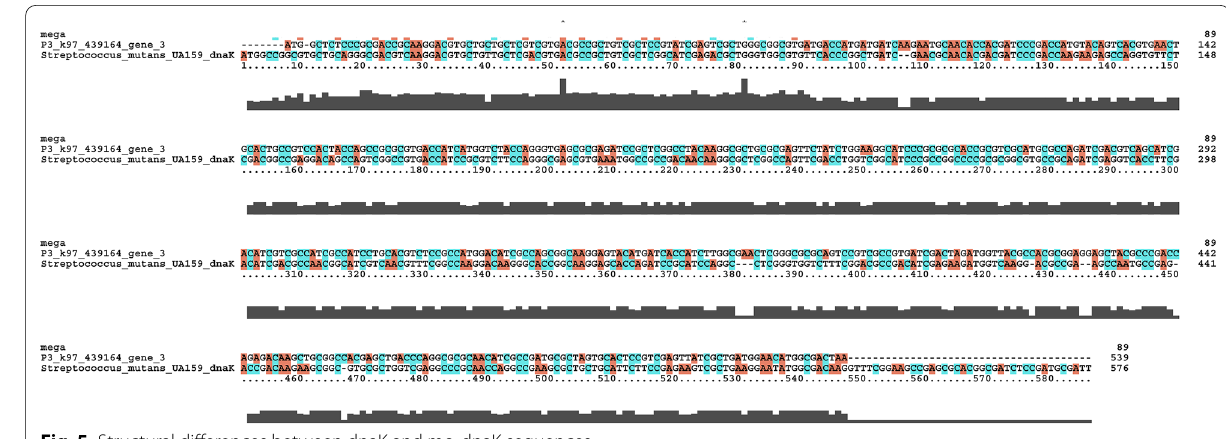
Fig. 5 Structural differences between dnaK and mo-dnaK